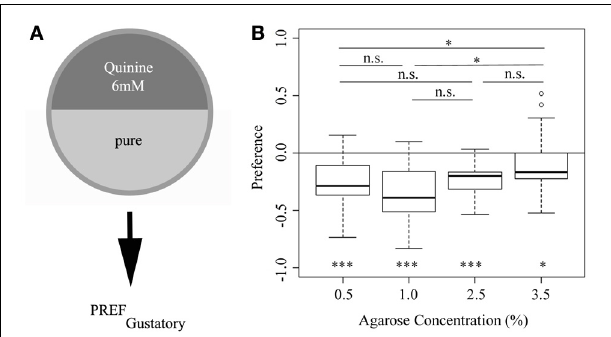
FIGURE 1 | Larval choice behavior for 6mM quinine avoidance on different agarose substrates. (A) Overview of the experimental setup to test for larval choice behavior using 6mM quinine. (B) Wild-type larvae avoid a 6mM quinine-agarose mixture vs. pure agarose in a choice assay using different agarose concentrations (significance against zero is shown at the bottom of the plot: p < 0 . 001 for 0.5, 1.0, and 2.5% agarose; p < 0 . 5 for 3.5% agarose). Larvae are significantly less repelled, if tested at an agarose concentration of 3.5% compared to 0.5 and 1.0% ( p < 0 . 05 in both cases). Thus, the agarose concentration used affects the behavioral output shown in this choice assay. Sample size n > 12 for each group. Small circles indicate outliers. ∗∗∗ p < 0 . 001; ∗ p < 0 . 05; n.s., not